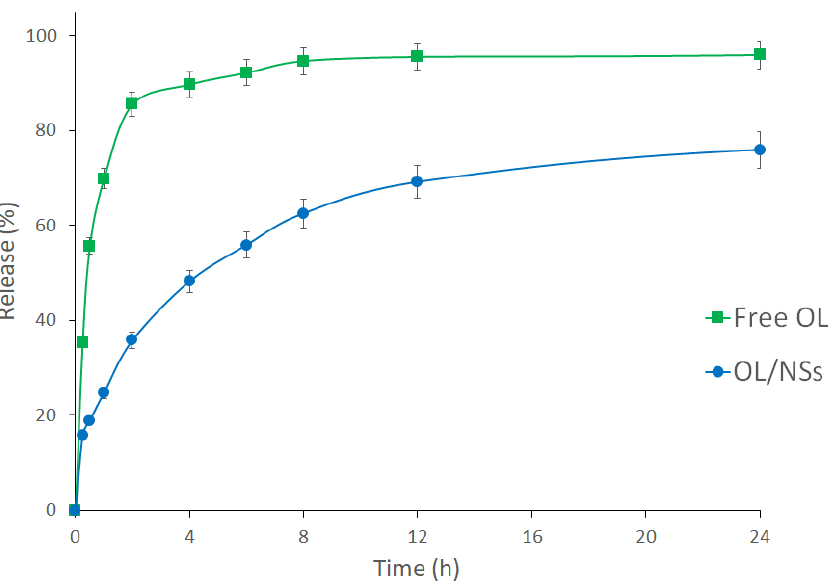
Figure 4. In vitro release profiles of free OL (square) and OL/NSs (circle) at 37 °C and pH 5.5 up to 24 h.